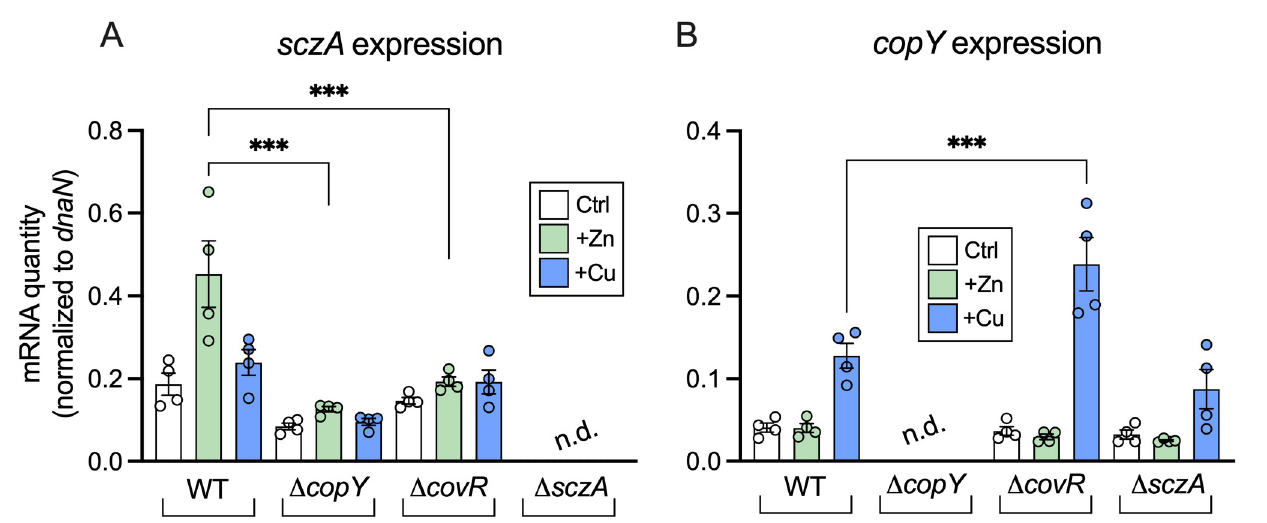
Fig 4. Cross-regulation of Zn and Cu stress responses by copY and covR . Transcripts of sczA (A) and copY (B) were quantified by qRTPCR from cultures of WT, Δ copY , Δ covR and Δ sczA mutants supplemented with Zn (0.25 mM) or Cu (0.5 mM) and compared to non-exposed (THB only) controls ( n = 4). Absolute transcript amounts were normalized using housekeeping dnaN and generated from standard curves using GBS genomic DNA. Transcripts of sczA and copY were not detected (n.d.) in the Δ sczA and Δ copY mutant strains, respectively. Quantities were compared using ordinary one-way ANOVA and Holm Sidak multiple comparisons ( ��� P <